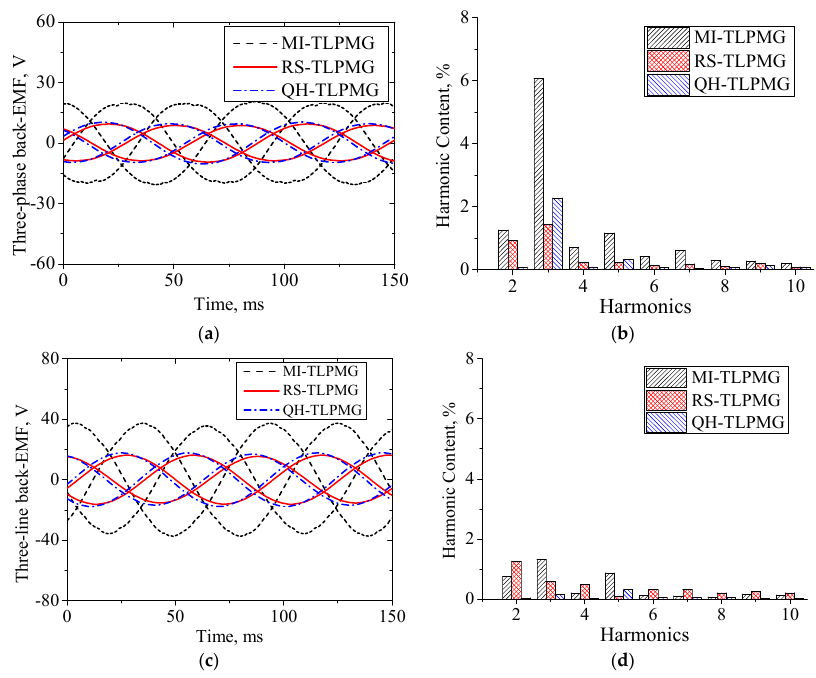
Figure 6. Back-EMF of the three different machines at the constant speed of 0.4 m/s: ( a ) three-phase back-EMF waveforms, ( b ) harmonics of phase back-EMF waveforms; ( c ) three-line back-EMF waveforms; ( d ) harmonics of line back-EMF waveforms.